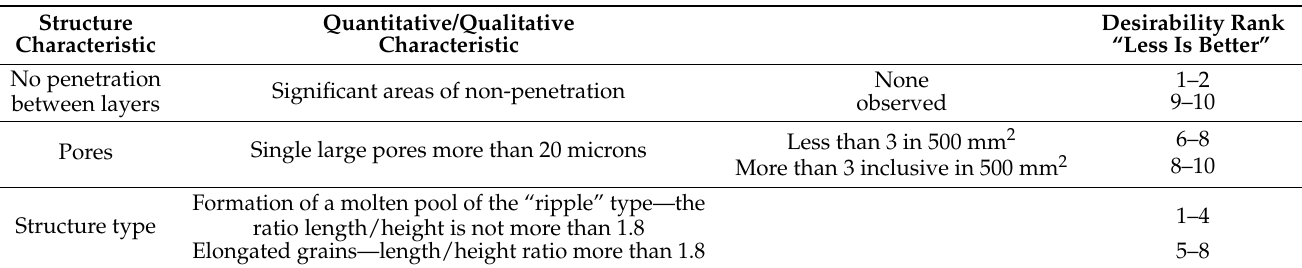
Table 4. Rank assessment of a qualitative characteristic.